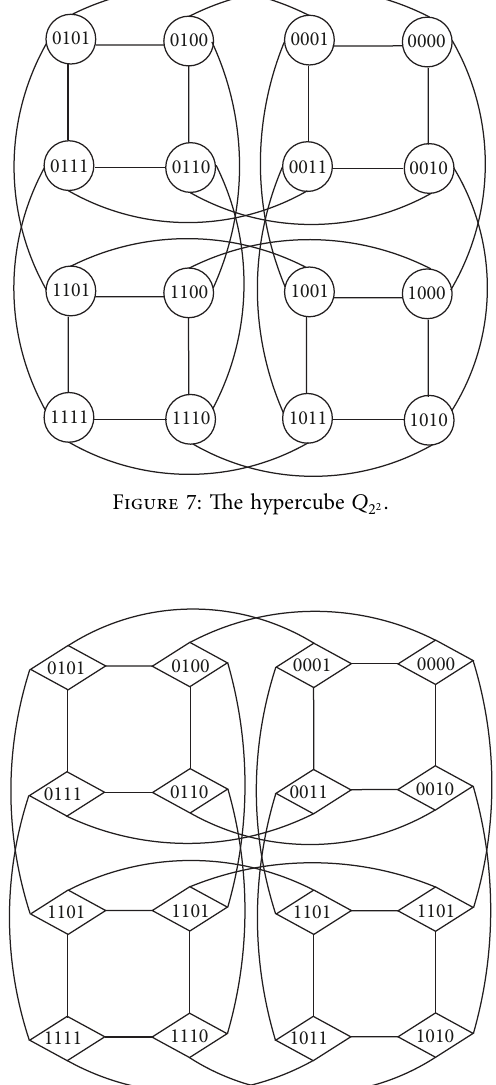
Figure 8: Te 6-dimensional hierarchical hypercube HHC